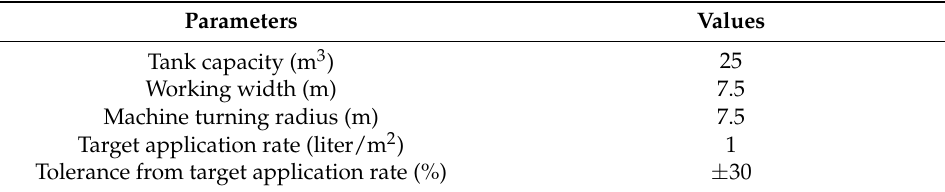
Table 4. The characteristics of the sample field and the distributer.